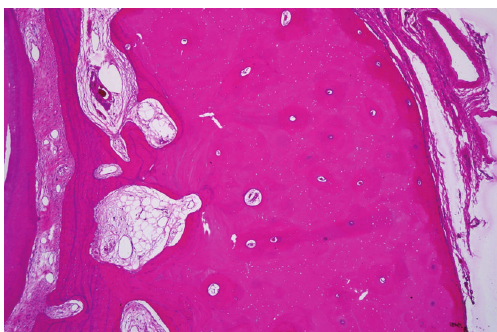
Figure 4: Ameloblastic fibro-odontoma showing ameloblastoma- tous epithelium, embryonal myxoid pulp tissue and dentin as well as enamel matrix.